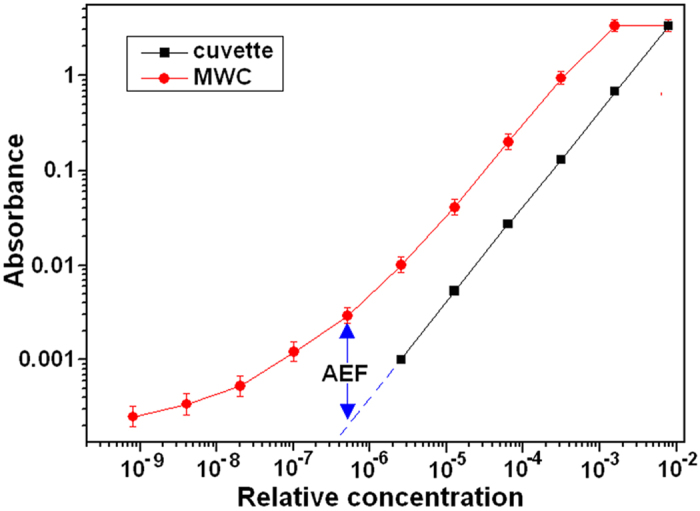
The relationship between the absorbance and concentration of the red-ink samples.